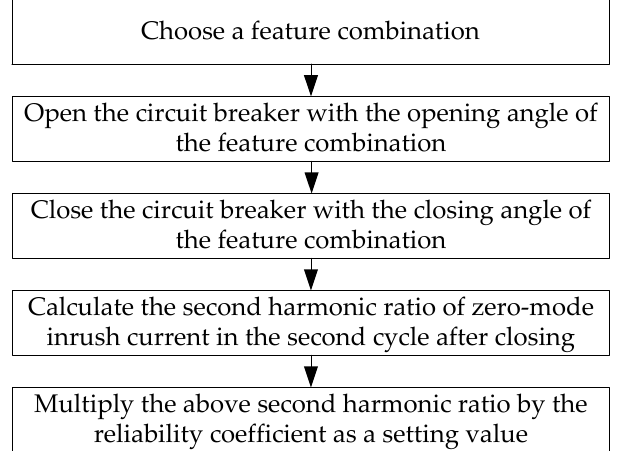
Figure 11. The operation of setting method in engineering application.